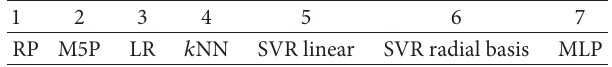
Table 10: Index notation for the nonensemble